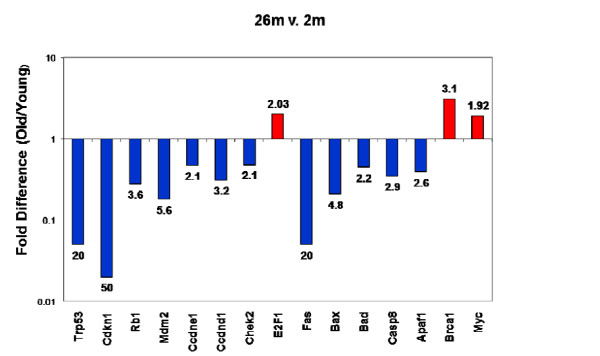
RT-PCR confirmation of age-related changes of cell cycle and apoptosis genes.  A RT-PCR (cancer) SuperArray of 84 cell cycle and apoptosis genes was used to compare mRNA from 2m and 26m mouse MSCs.  The analysis confirms 2-fold and 50-fold decrease of p53 and p21 respectively and significant decrease of apoptosis transcripts with age.